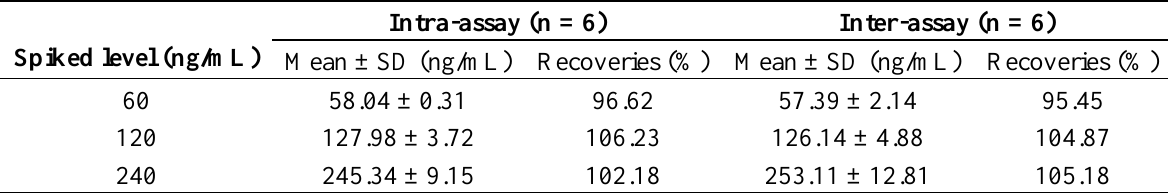
Table 2. Recovery of Arah1 from spiked pure